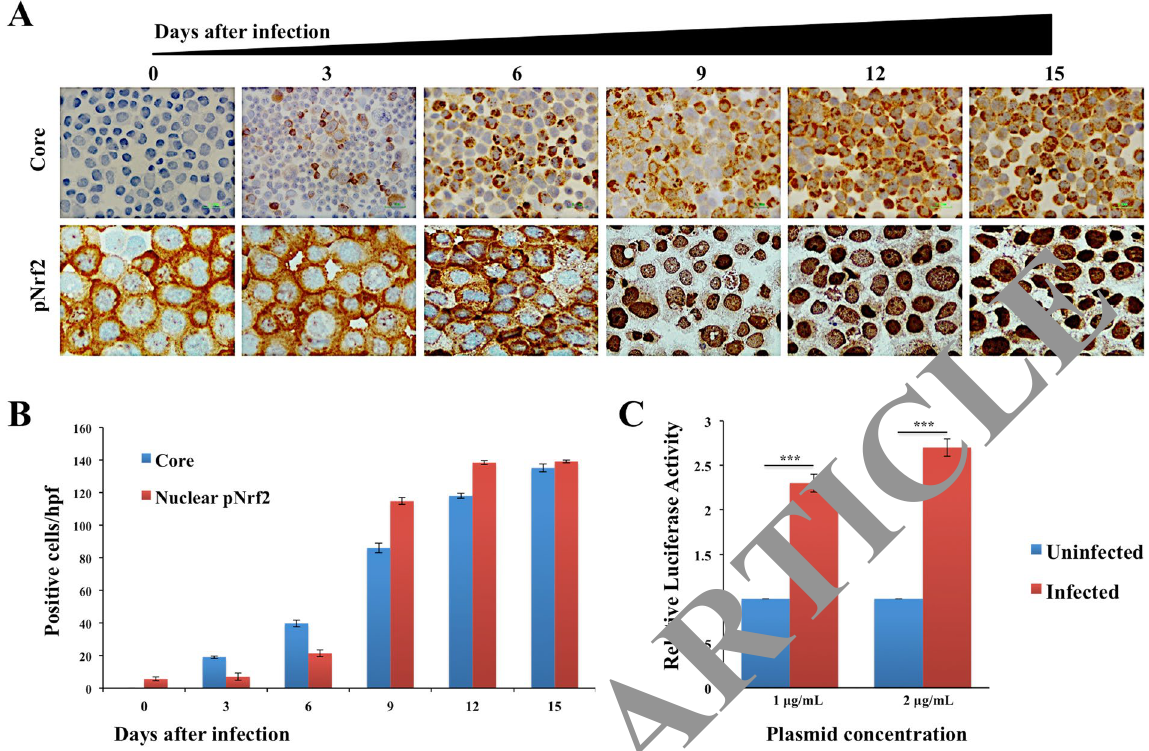
Figure 4. Persistent HCV replication induces Nrf2 activation and nuclear translocation. (A) Immunocytochemical staining of HCV core and pNrf2 in HCV infected Huh-7.5 cells at different days after HCV infection. (B) Quantification of core positive and Nrf2 positive infected Huh-7.5 cells, three high-power fields were measured using ImageJ software. *** P < 0. 0001. (C) Activation of ARE-luciferase reporter in uninfected and HCV infected cells at day 12. Two different concentrations of ARE-luciferase plasmid were transfected to Huh-7.5 cells and infected Huh-7.5 cells. After 24 hours, equal amounts of protein lysates were measured for luciferase activity. The luciferase values were normalized to one microgram of